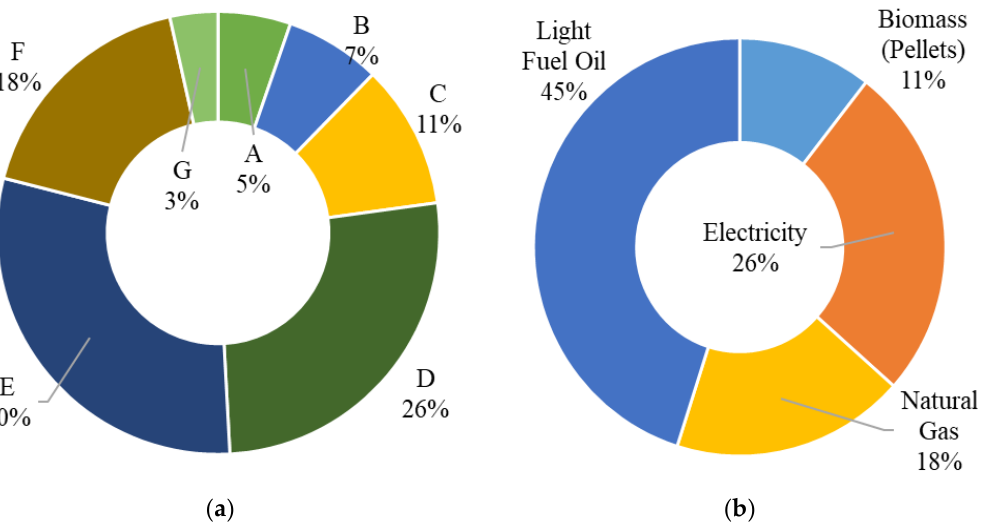
Figure 5. ( a ) Distribution of the EPC energy label regarding the CO 2 emissions and ( b ) share of the fuel used for the heating system per total heated area.